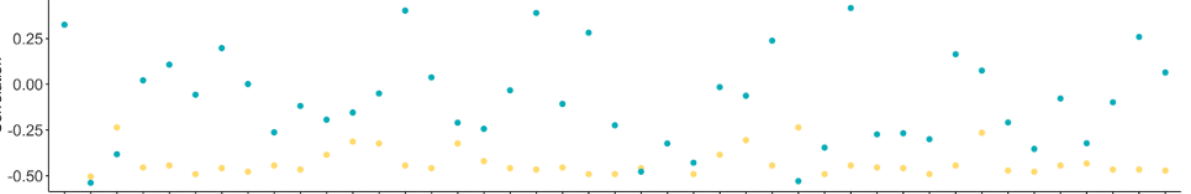
Figure 6. Correlation between confirmed COVID-19 cases or mobility and proportion of tweets about social distancing by US state. Most states have a moderate negative correlation between the proportion of tweets about social distancing and mobility data (yellow), indicating good agreement in the two signals. Some states have notably weaker negative correlations (eg, AR, NM, and RI), which could be the result of less Twitter data. Correlations between the number of confirmed COVID-19 cases and the proportion of tweets about social distancing are weak (blue), with a few notable exceptions (eg, AL). 2-letter abbreviations are used for each